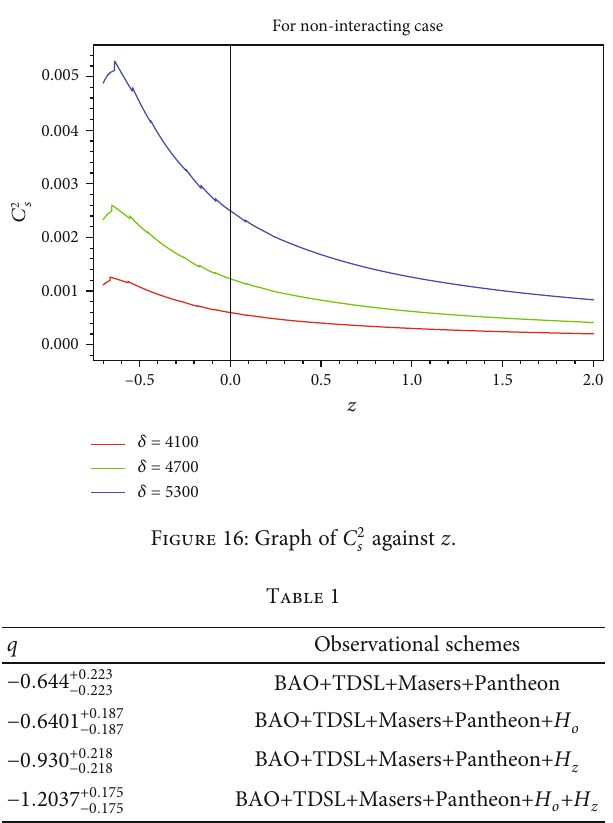
Figure 15: Plot of squared speed of sound C 2 parameter z .